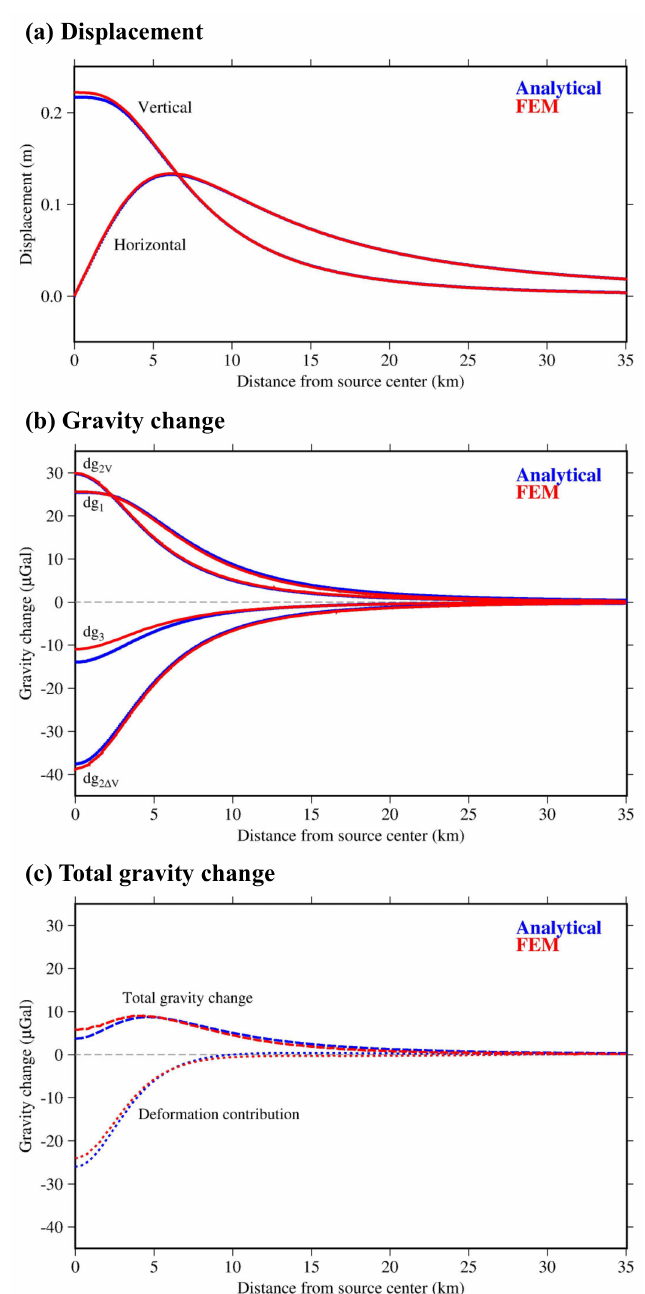
Figure A1. Benchmark test. Comparison between analytical (blue) and numerical (red) solutions for an ellipsoidal source in a homogeneous space with no topography. All solutions are shown along a radial distance centered at the source horizontal position. ( a ) Comparison of horizontal and vertical displacement at the free surface. ( b ) Comparison between the various components of gravity changes at the surface. ( c ) Total gravity change obtained by summing all the components shown in ( b ) and the gravity change only due to the contribution of deformation ( δ g 1 + δ g 2 ∆ V + δ g 3